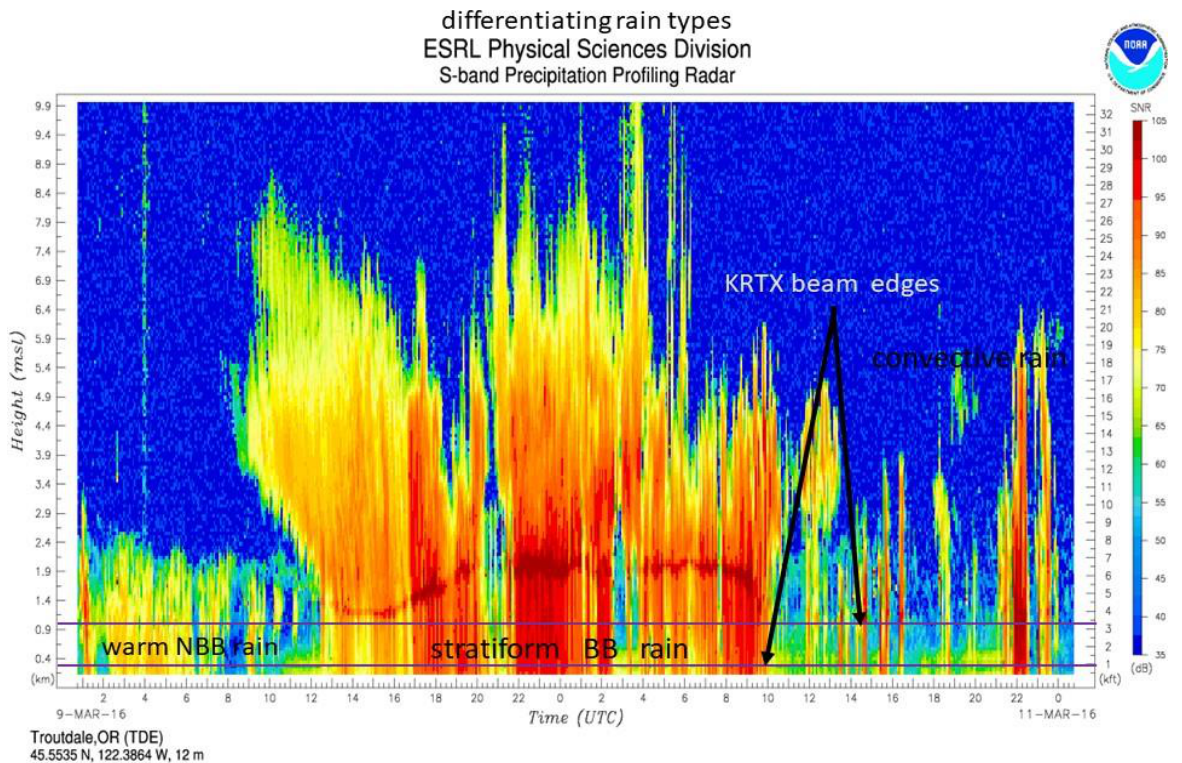
Figure 2. A time-height cross-section of signal-to-noise TDE S-band profiler (S-Prof) radar returns during the 9–10 March 2016 precipitation event. Horizontal thin purple lines show estimates of the upper and lower edges of the KRTX radar resolution volume at the lowest beam tilt of 0.5°.